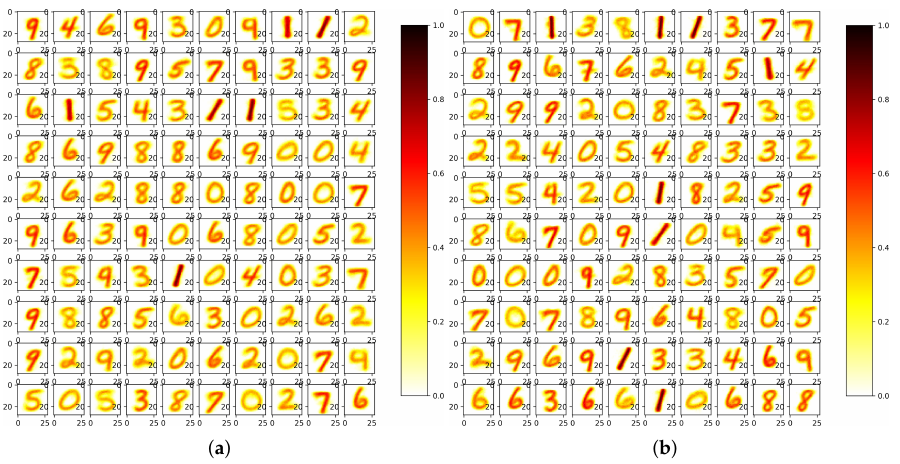
Figure 3. Weight results of neurons according to 180,000 number of iterations (NOI) when ( a ) the conventional V th variation-based adaptation and ( b ) the sensory adaptation is